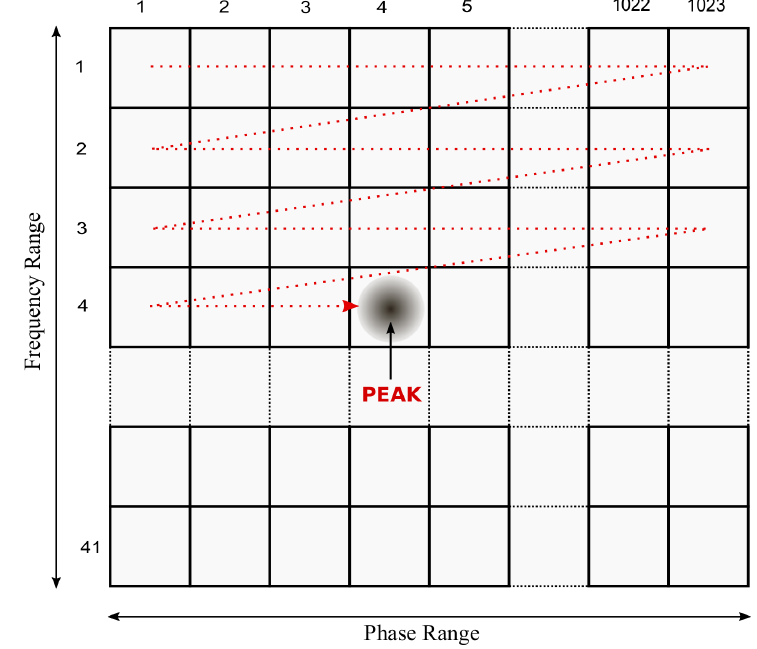
Figure 2. Conventional Acquisition